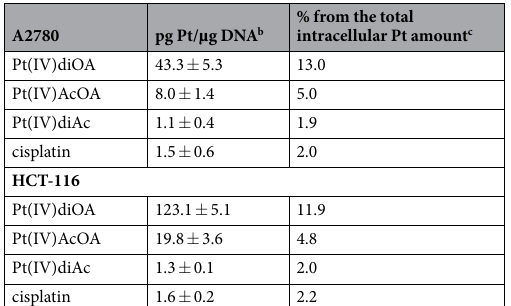
Table 3. Platinum content on DNA isolated from A2780 and HCT-116 cells treated with cisplatin and its Pt(IV) derivatives a . a Cells were treated for 24 h with tested compounds (0.35 µ M). b Platinum content on DNA from A2780 and HCT-116 expressed in pg of Pt per µ g of DNA. Results are expressed as the mean ± SD for three independent experiments with triplicate for each run. c The values represent platinum content on DNA from A2780 and HCT-116 cells expressed as the percentage of the total platinum accumulated inside these